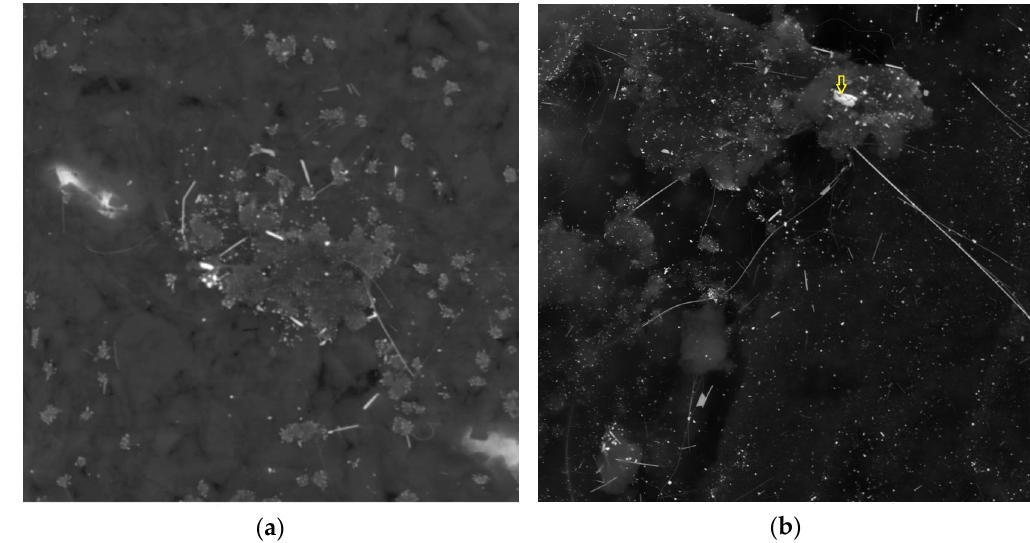
Figure 6. Platinum alloys in experimental samples ( a ) BSE micro-image of carbon and MgO coated platinum capsule wall from experiment qz121; Pt/Fe atomic ratio is 4.2 ± 0.6; different morphology of Pt particles from dot to hair-like can be seen (image width 76 µm) ( b ) BSE micro-image of carbon and MgO coated platinum capsule wall from experiment qz122 (image width 76 µm); platinum particle from the wall is labeled with an arrow. Table 2. Content of acetone-soluble Pt form in fluid traps and in washes from capsule walls. Run